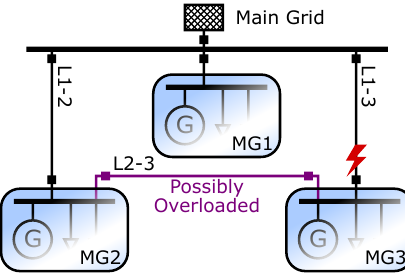
Figure 1. Exemplary